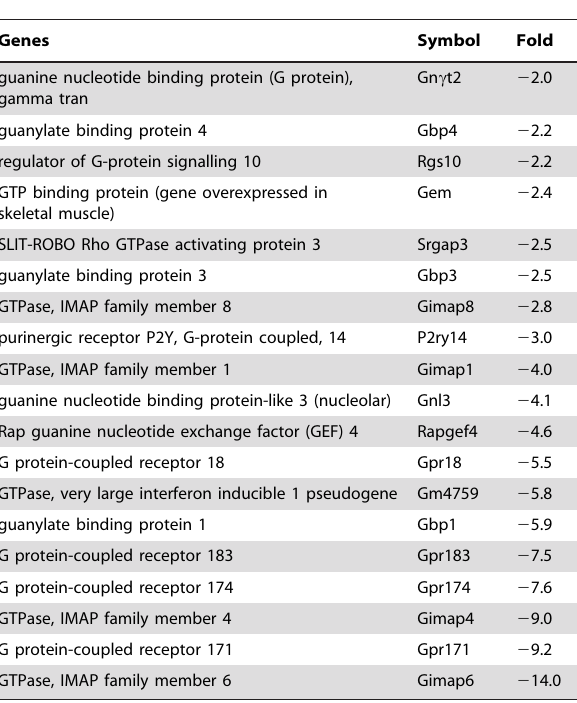
Table 2. Decreases of large G-protein superfamily in lal 2 / 2 bone marrow